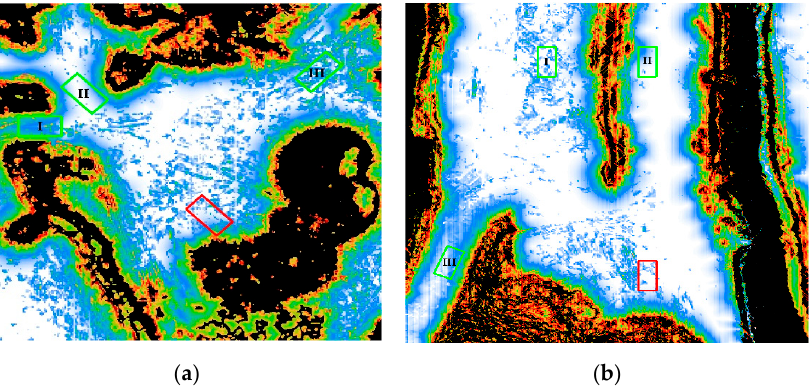
Figure 13. Schematic diagram of start and goal position of truck in two scenes. ( a ) is the map of scene 1; ( b ) is the map of scene 2. The green square frame represents the starting position and the red square is the goal position.